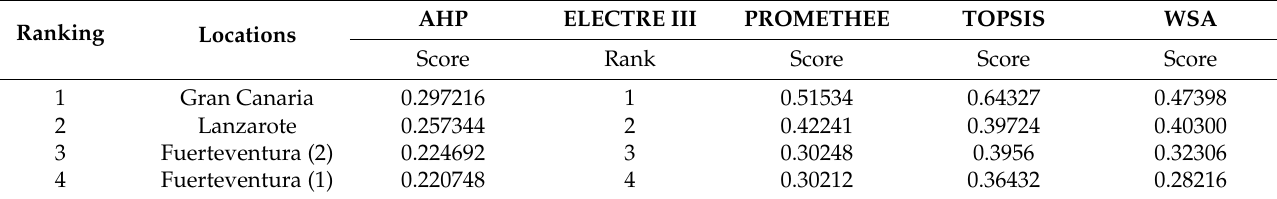
Table 7. Ranking of locations with the different multicriteria decision methods.